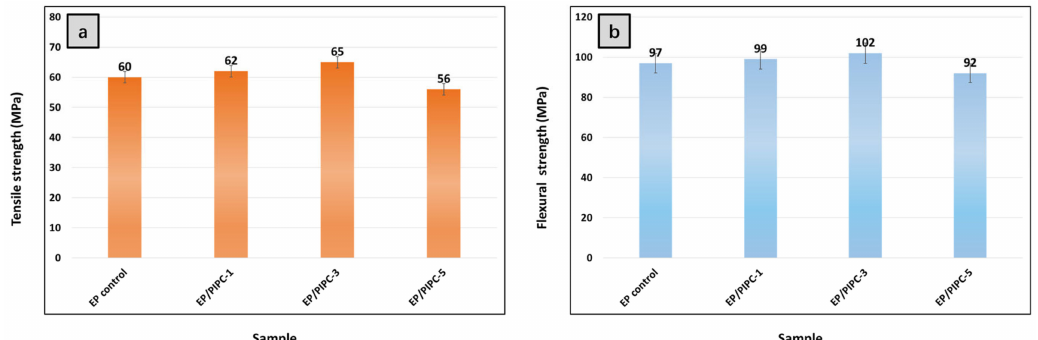
Figure 14. ( a ) The tensile strength and ( b ) flexural strength values of EP and its